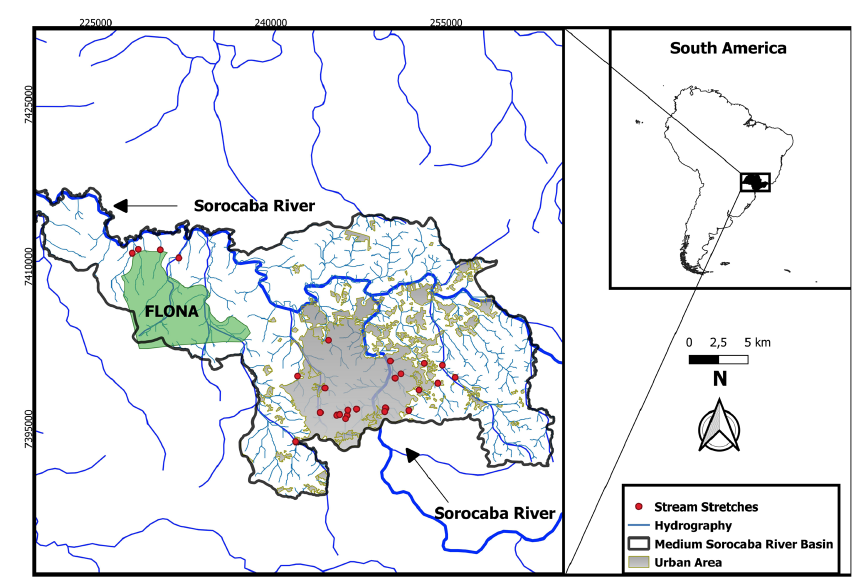
Figure 1. State of São Paulo, Medium Sorocaba River Basin and stream stretches sampled in Sorocaba City and FLONA-Ipanema (Datum SAD 69, UTM